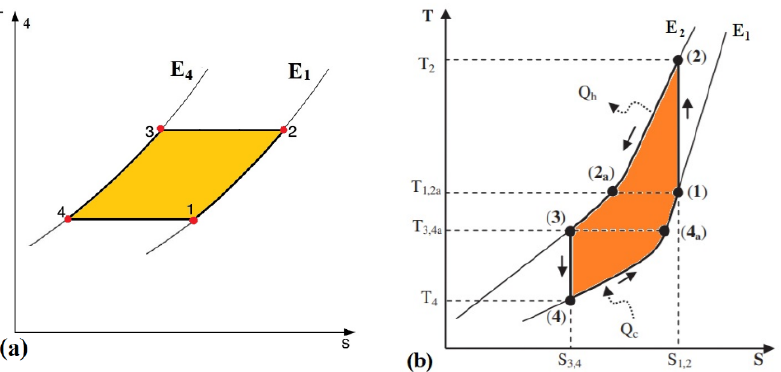
Figure 2. The four processes of the Brayton cycle for electrocaloric cooling: ( a ) Without and ( b ) with regeneration.